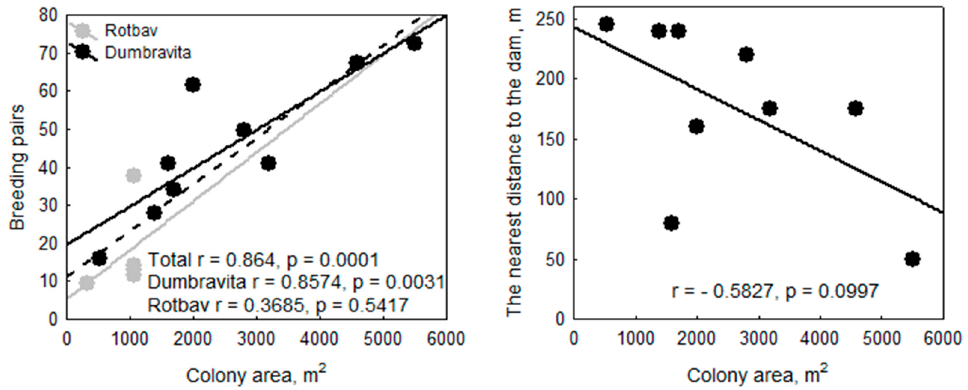
Figure 9. Relation between breeding pairs and colony area separated by ( left ) both colonies and ( right ) between nearest distance to dam and colony area.